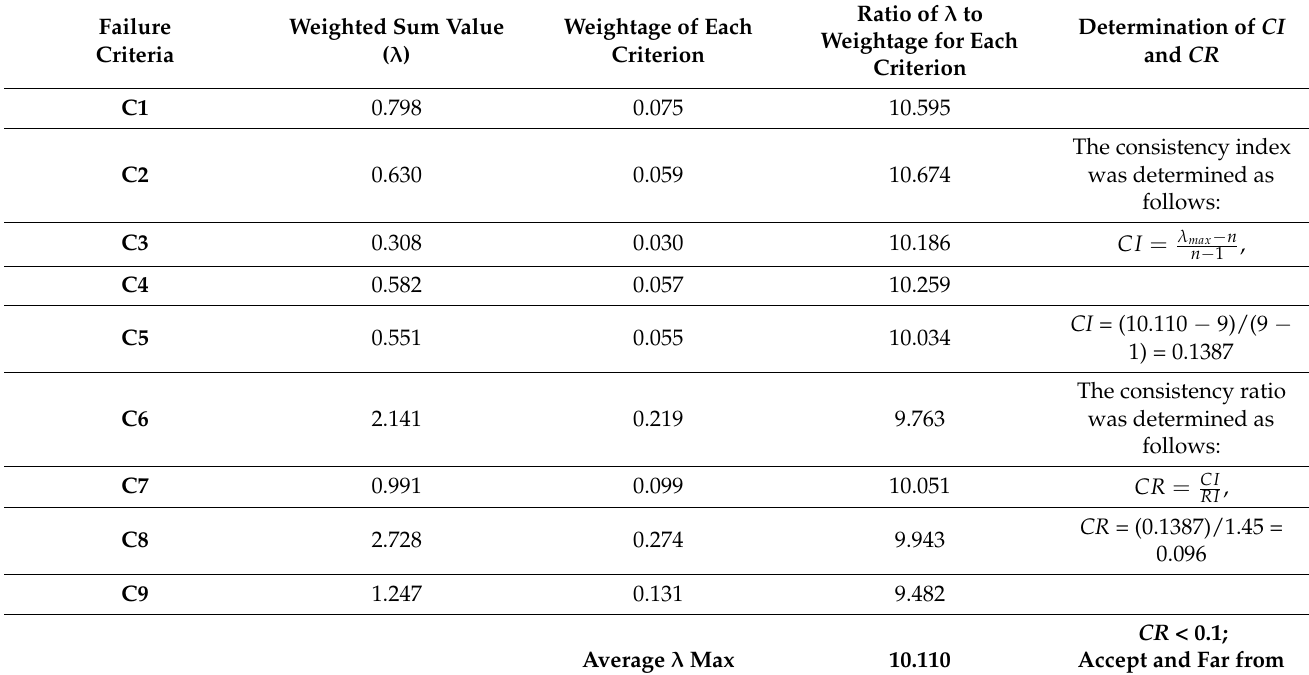
Table 8. The sensitivity checking procedure for all the PCMs values in Table